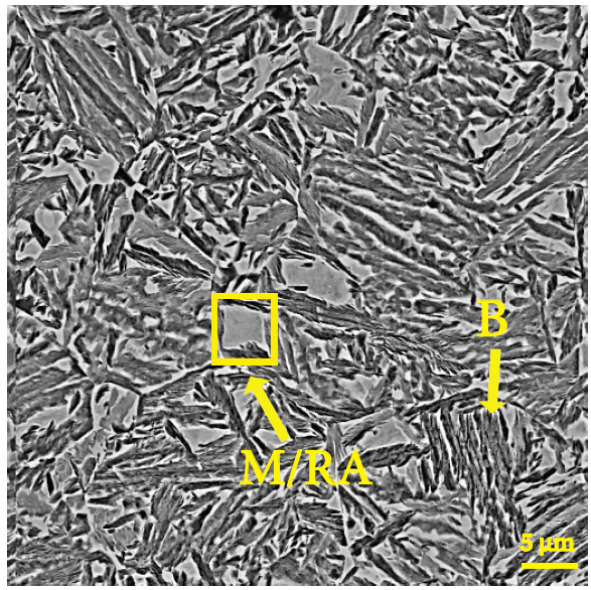
Figure 7. A field emission scanning electron microscopy–backscattered electron (FE-SEM BSE) micrograph of the Q&B specimen held in the molten salt bath at 350 °C for 200 s, followed by water cooling to the ambient temperature. The abbreviations B and M/RA represent bainite and martensite/retained austenite phase constituents, respectively.